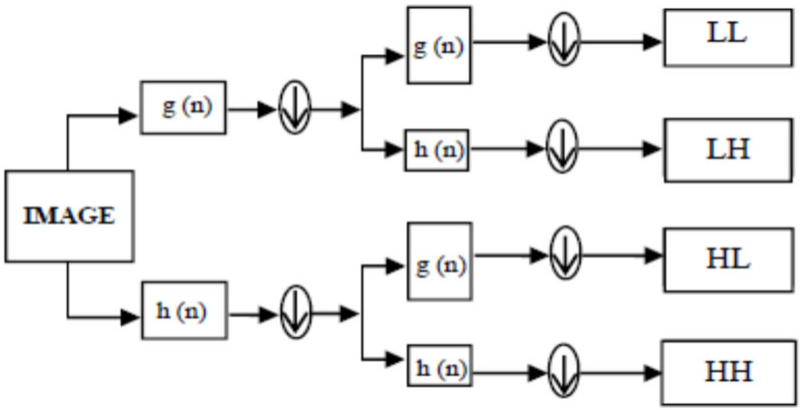
Figure 1. 2-level DWT using filtering